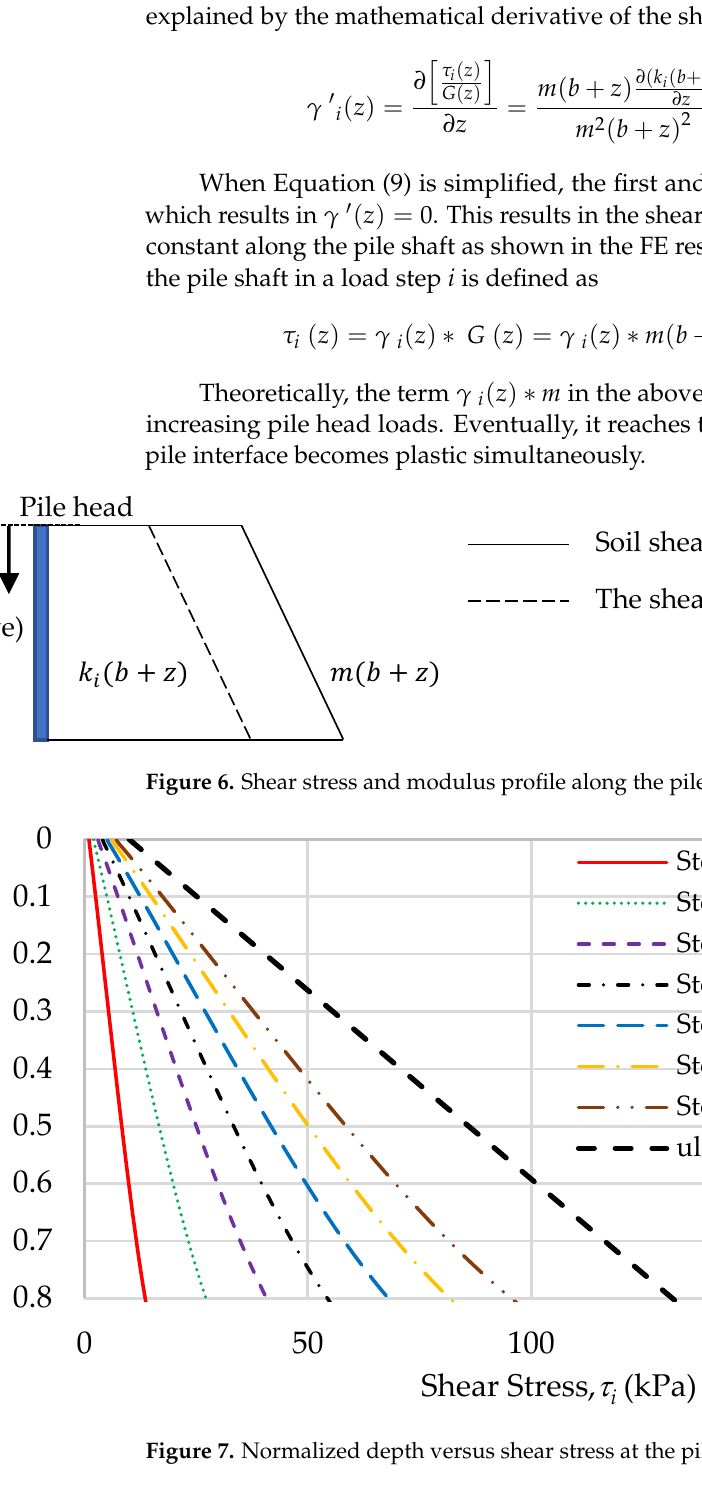
Figure 7. Normalized depth versus shear stress at the pile shaft in a load step, from FE analysis.